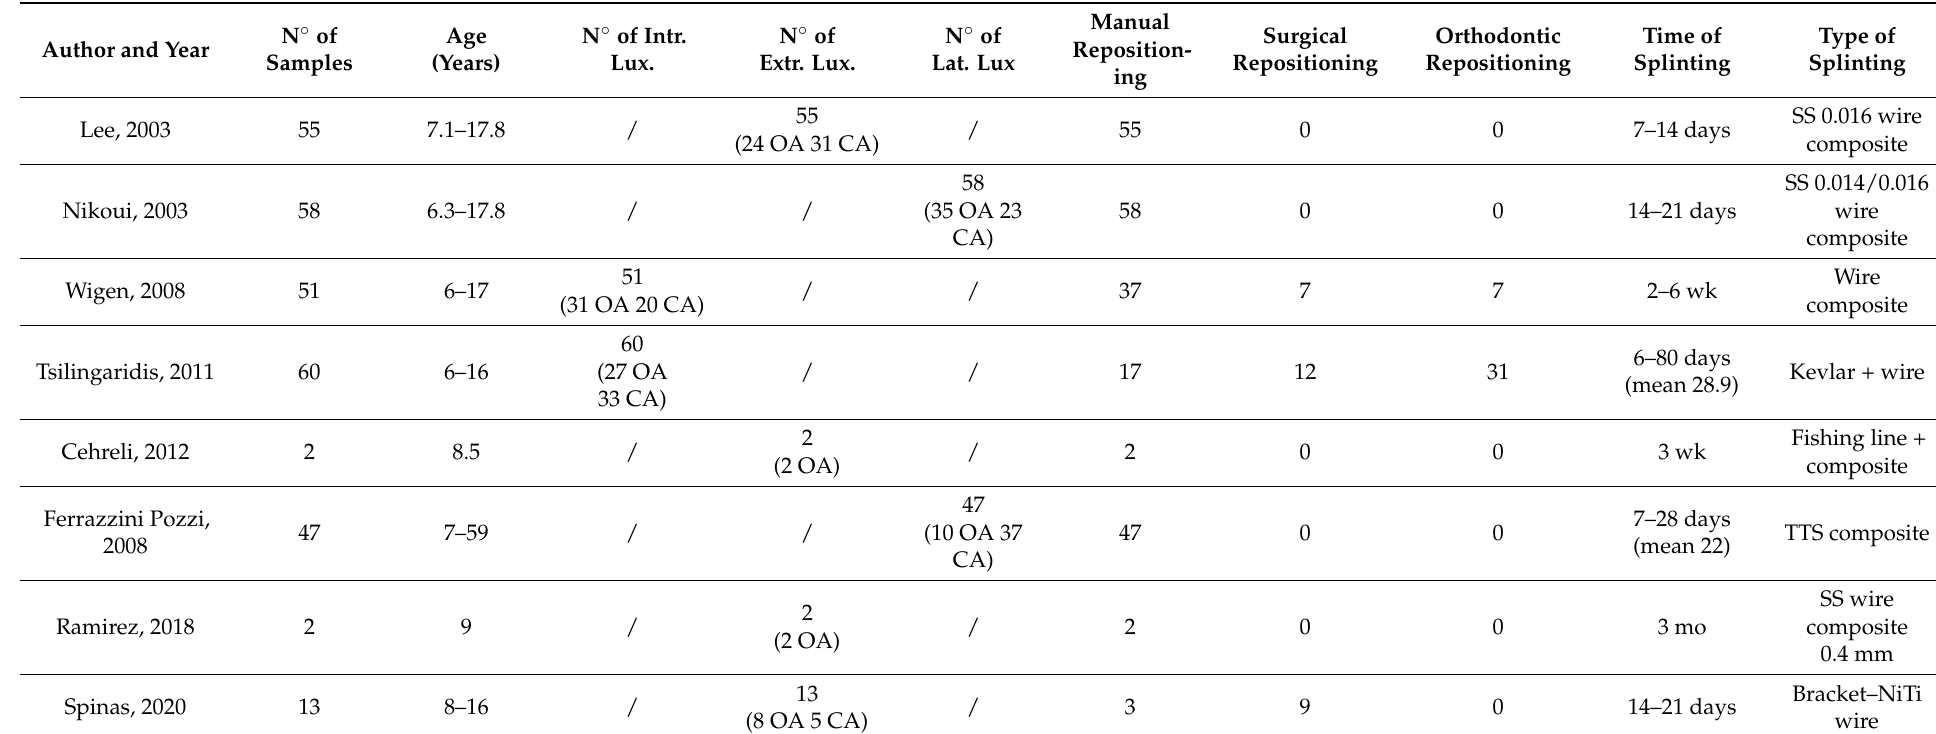
Table 2. The table shows the type of treatment choice, materials, and time of